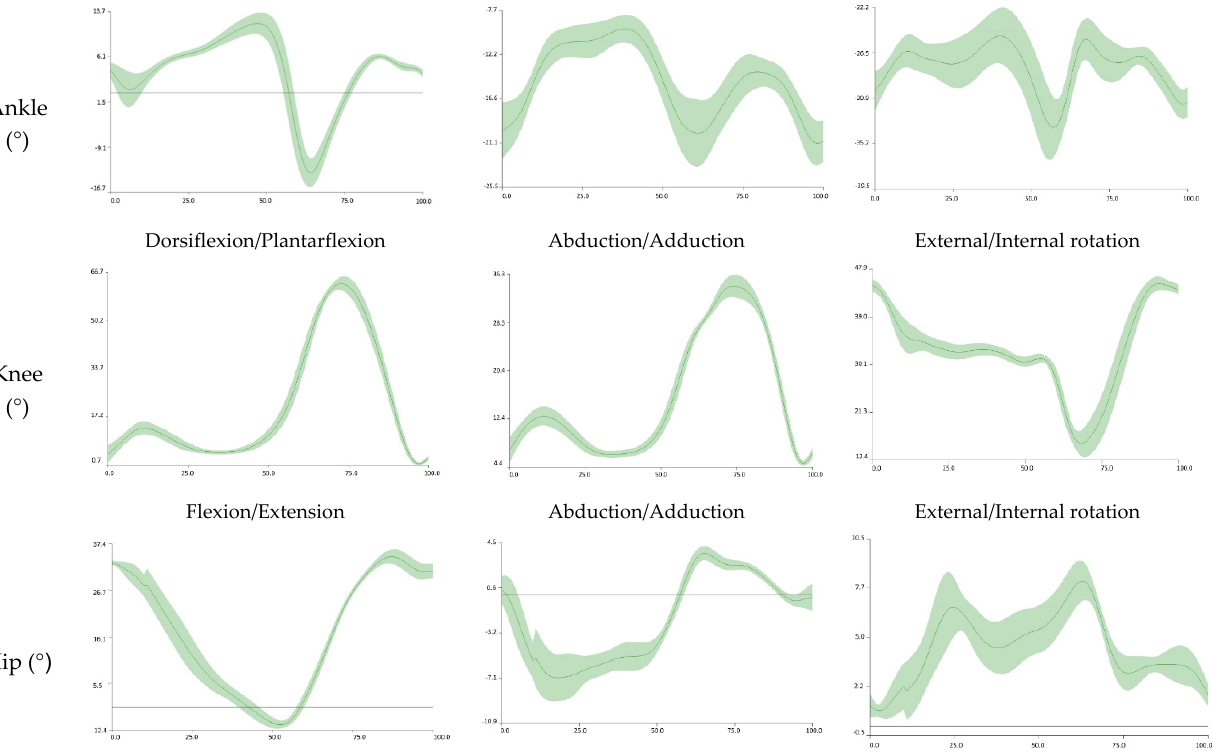
Figure 1. Kinematics of various NF lower limb joints during gait.